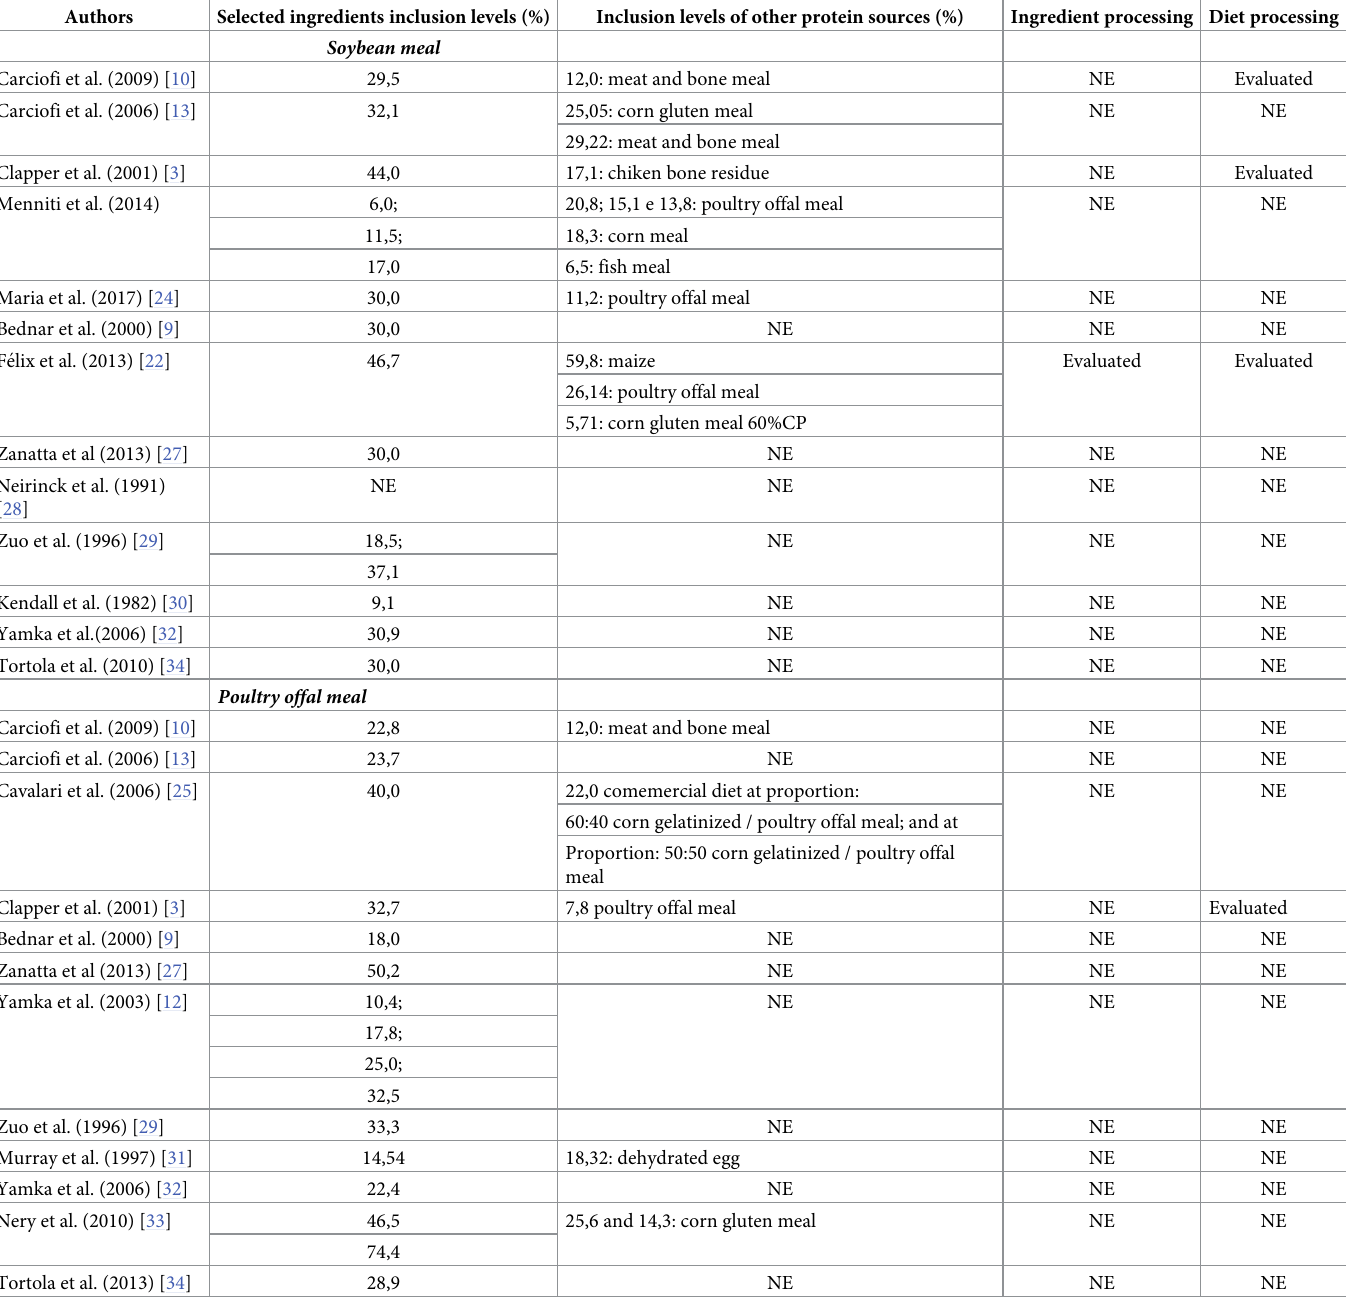
Table 3. Inclusion levels of soybean meal, poultry offal meal and other protein sources evaluated in the studies and adults dogs diets processing information.